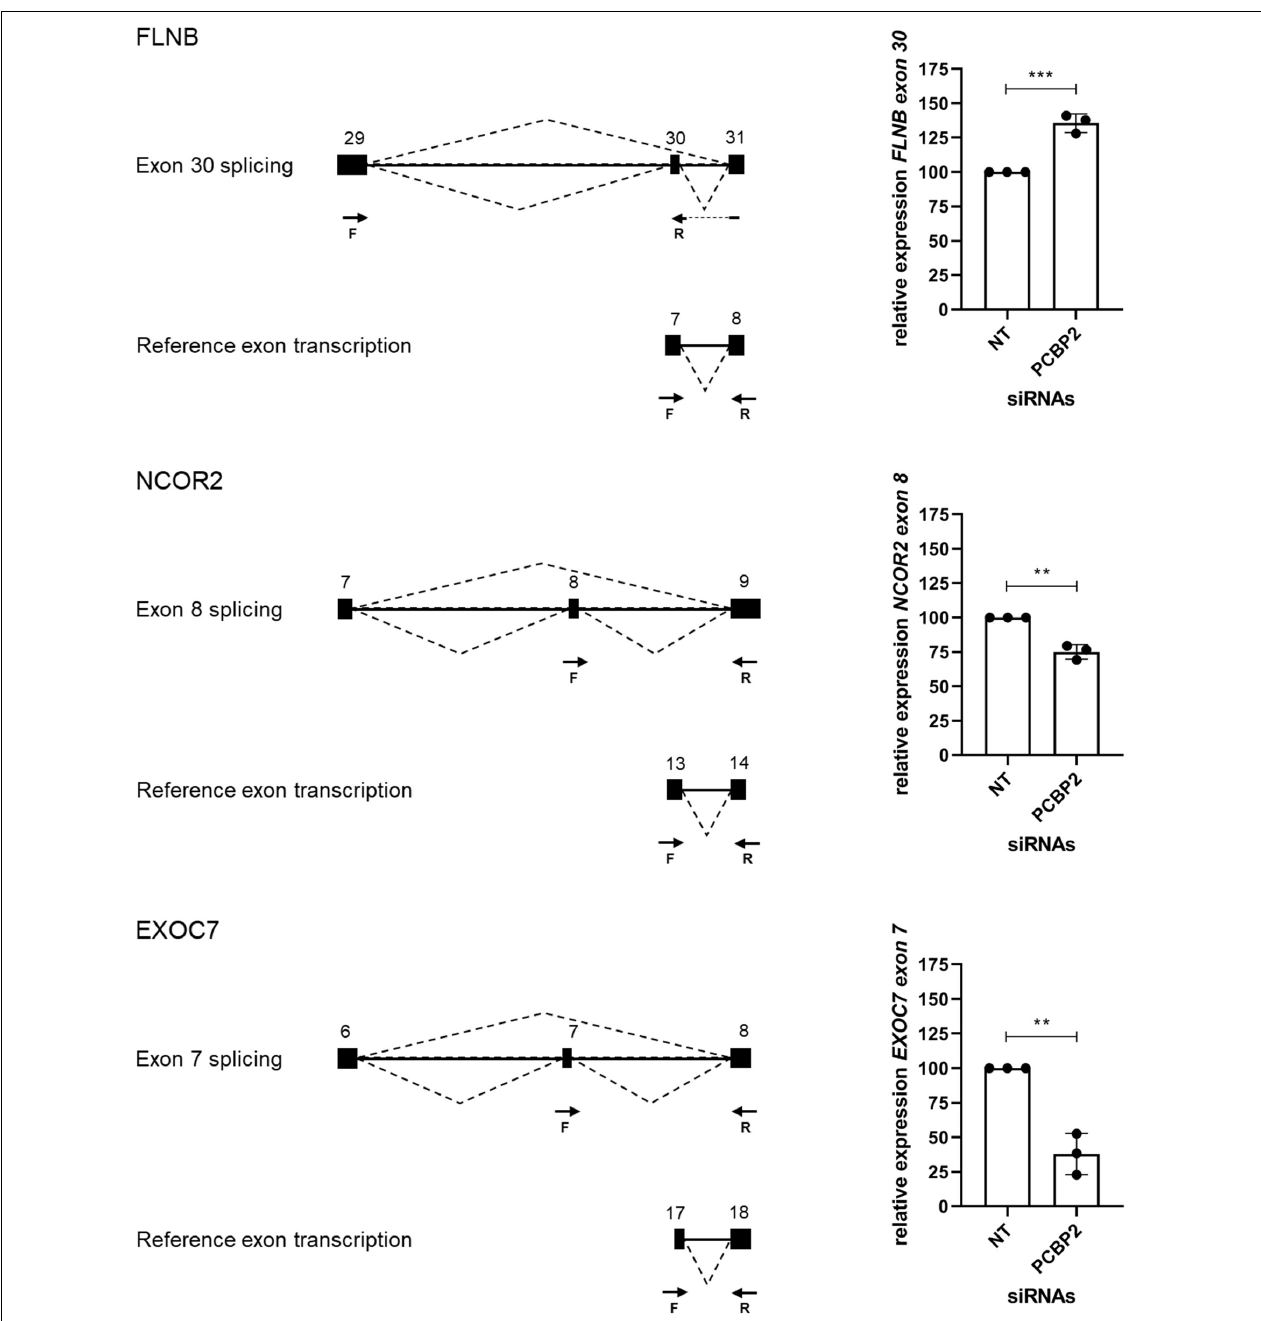
FIGURE 4 | Validation of PCBP2 knockdown effect on splicing. Validation by qPCR of three genes identified by RNA-Seq to undergo transcript switching upon silencing of PCBP2. Transcription of reference exons of each of the genes was used for normalization. The specific included or excluded exons are depicted in the diagrams which also indicate the location of the primers used (forward [F] and reverse [R]). FLNB shows significant inclusion of exon 30 upon PCBP2 silencing, while NCOR2 and EXOC7 show significant exclusion of exon 8 and 7, respectively. Experiments were repeated three times using 3–4 replicates per treatment. Data are presented as mean ± SD and tested with a Student’s t -test. ** Indicates p < 0.01; *** indicates p <